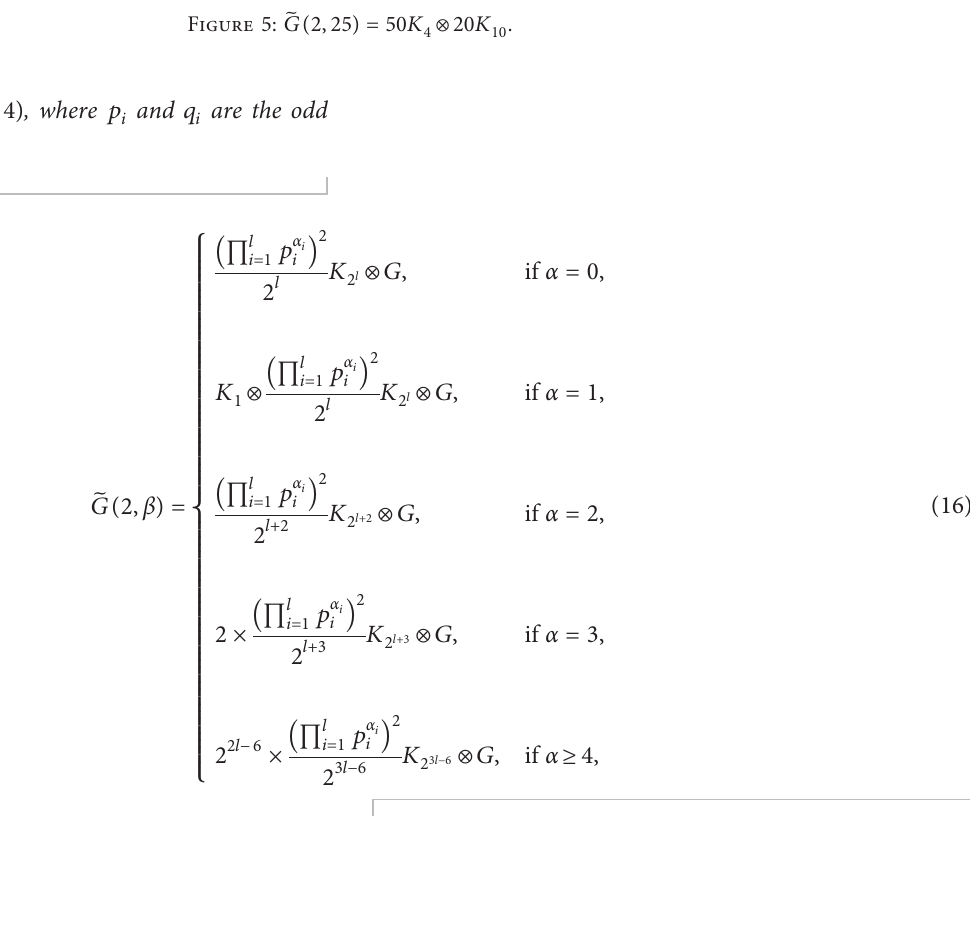
Figure 5: 􏽥 G ( 2 , 25 ) � 50 K